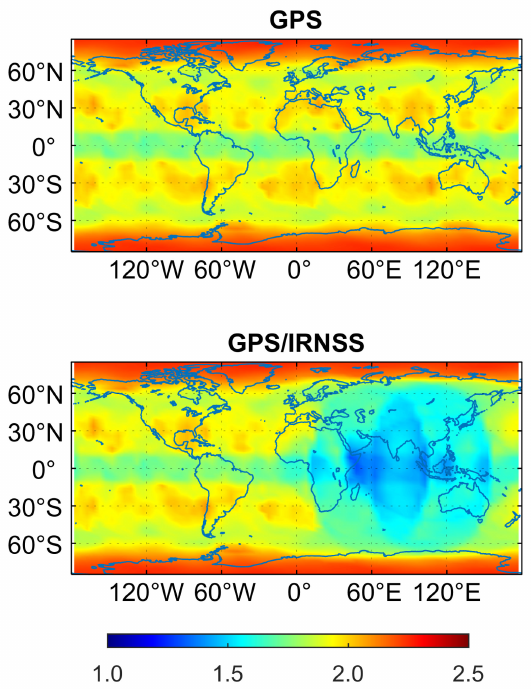
Figure 8. Average value of PDOP for GPS-only case and GPS/IRNSS